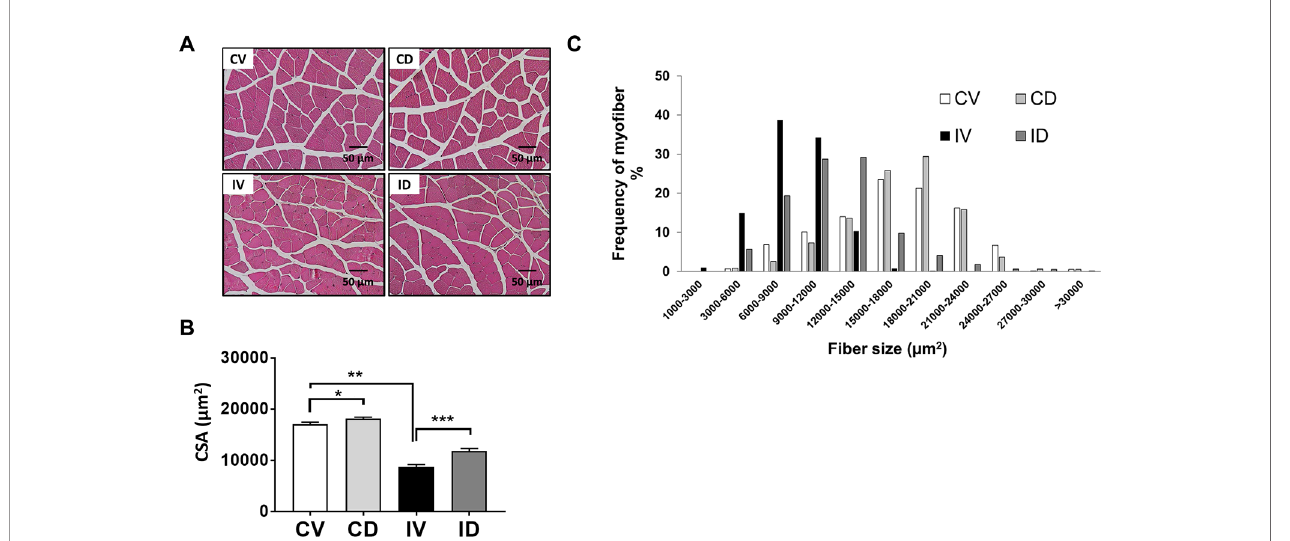
FIGURE 2 | Dulaglutide treatment increased muscle fi ber size in disuse-induced skeletal muscle atrophy. (A) GA muscle tissue sections were stained with H&E and examined under microscope. (B) The cross-sectional area (CSA) of muscle fi ber was measured using ImageJ program and the average CSA is shown. (C) Distribution of myo fi ber size. Data are shown as means ± S.E.M, n = 5; *p < 0.05, **p < 0.01, ***p < 0.001 versus control + vehicle or immobilization + vehicle group. CV, control + vehicle; CD, control + dulaglutide; IV, immobilization + vehicle; ID, immobilization +